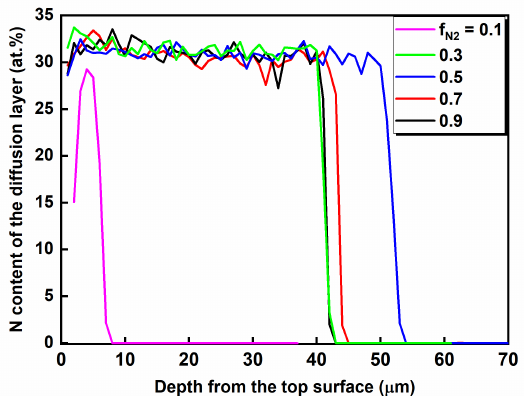
Figure 4. Electron probe microanalysis results show the nitrogen content within the diffusion layer of nitrided FeAl40 alloy.